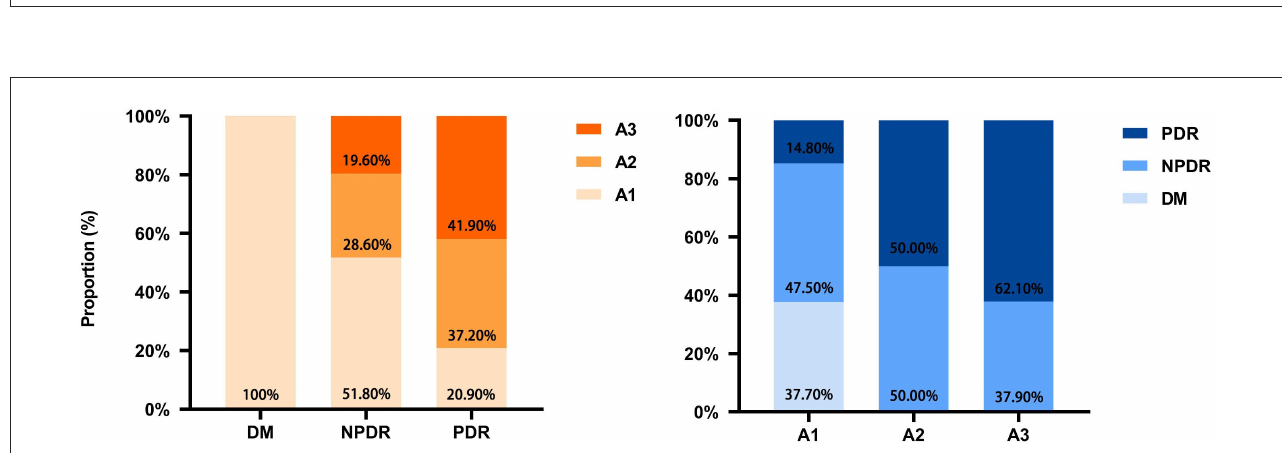
FIGURE4 Correlation and proportion between DR and DKD grades. DM, diabetes mellitus; DR, diabetic retinopathy; DKD, diabetic kidney disease; A1, A2, A3, albuminuria categories DKD to three classes (A1–A3); A1, normal to mildly ( < 30 mg/g); A2, moderately (30–299 mg/g); A3, severely increased ( ≥ 300